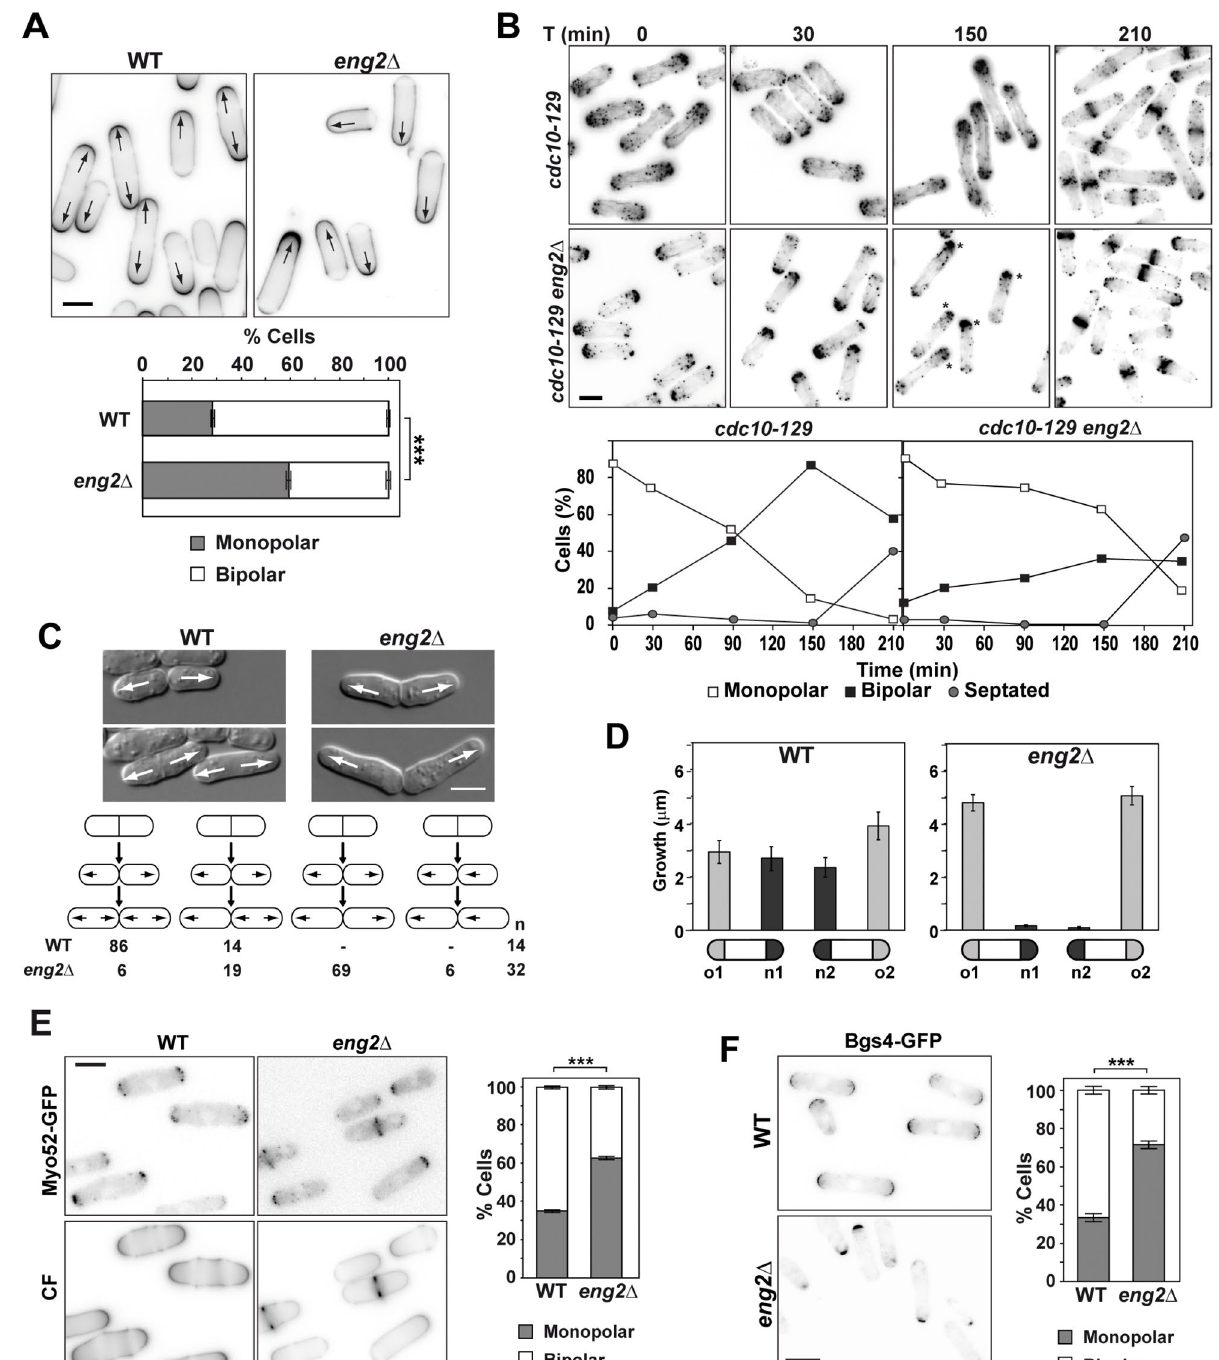
Figure 1. eng2 Δ cells have NETO defects. (A) Calcofluor white staining of wild-type and eng2 Δ cells grown in EMM medium. Arrows indicate the growing poles. Scale bar, 5 μm. The graph represents the average ± s.e.m. percentage of monopolar or bipolar cells in each strain of 3 independent experiments (n > 150; ***p-value < 0.0001). (B) cdc10-129 and cdc10-129 eng2 Δ cells were arrested in G1 as monopolar cells by incubation at 36 °C and then released at 25 °C. Images show actin staining with Alexa Fluor 488 phalloidin at the indicated times (min) after release. Asterisks indicate cells with monopolar growth. The graphs represent the percentage of monopolar, bipolar and septated cells at each point. Scale bar, 5 μm. (C) Identification and quantification of growth patterns of wild-type and eng2 Δ cells by time-lapse microscopy. Arrows indicate the direction of growth. The percentage of cells with each growth pattern is indicated. Scale bar, 5 μm. (D) Total growth for each cell tip during the cell cycle for wild-type (n = 12) and in eng2 Δ (n = 22) daughter cell pairs (average ± s.e.m). Cells were grown on EMM during 4–5 h at 28 °C. (E) Localization of Myo52-GFP in wild-type and eng2 Δ cells. Images of Myo52-GFP and calcofluor staining (CF) in the same cells are shown (scale bar, 5 μm). The graph represents the average ± s.e.m. percentage of cells with monopolar or bipolar localization of Myo52-GFP in each strain for 3 independent experiments (n > 150; ***p-value < 0.0001). (F) Localization of Bgs4-GFP in wild-type and eng2 Δ cells. Fluorescence images are shown (scale bar, 5 μm). The graph represents the average ± s.e.m. percentage of cells with monopolar or bipolar Bgs4-GFP in each strain for 3 independent experiments (n > 150; ***p-value <